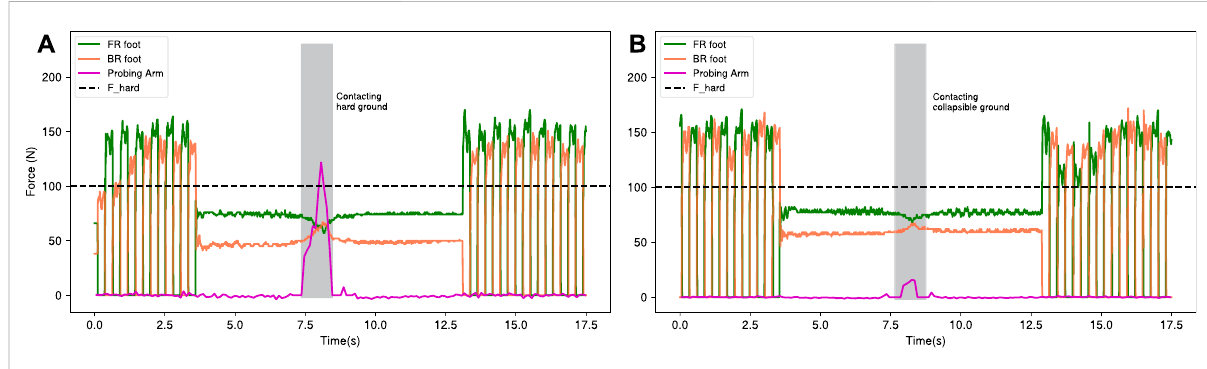
FIGURE 8 Forcemeasurementsoffront-right(FR),back-right(BR)foot,andtheprobingarm.Therobotwalksforward,stands,andprobes (A) hardground and (B) soft (collapsible) ground. From the fi rst scenario, it can be seen that the force sensing of theprobing arm is close to the reference F hard force, which corresponds to the hard ground characteristics in collapsibility estimation graph, and in the second case, the probing arm ’ s ground reaction force is relatively low compare to F hard force, indicating estimation of collapsible